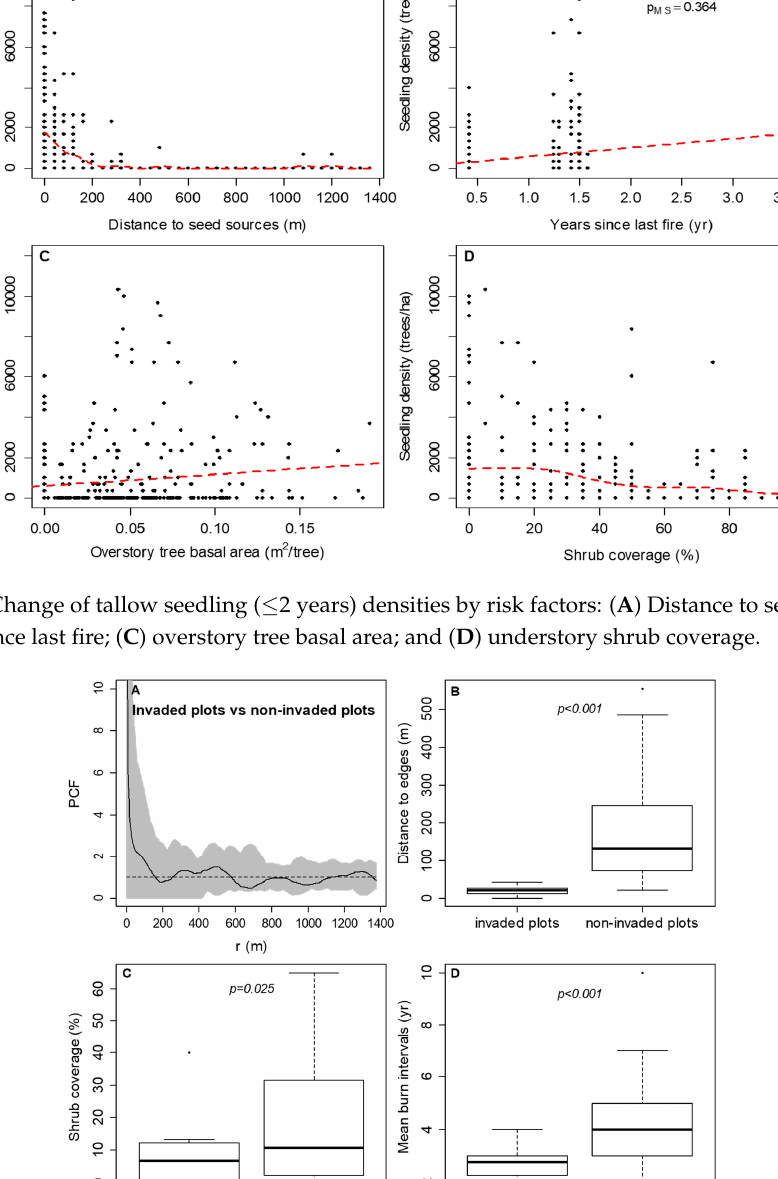
Figure 6. The spatial relationship and site conditions between tallow-invaded plots and non-invaded plots: ( A ) The PCF curve shows the invaded plots and non-invaded plots are spatially independent; ( B ) tallow-invaded plots are significantly closer to roads than non-invaded plots; ( C ) tallow-invaded plots have significantly lower shrub coverage than non-invaded plots; ( D ) tallow-invaded plots have significantly shorter mean fire return intervals than non-invaded plots.